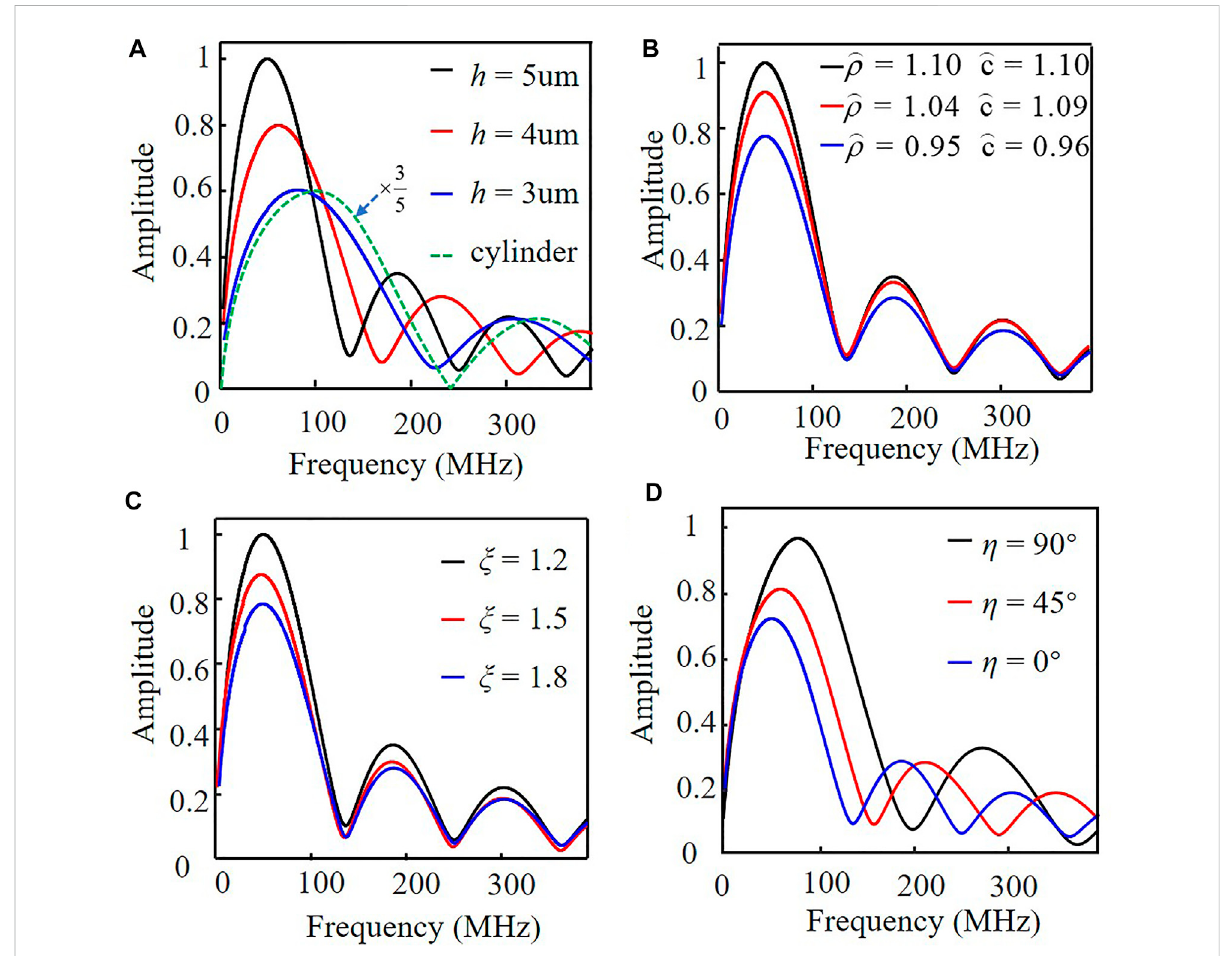
Calculated photoacoustic spectral amplitude ofthe fl uidic ellipticcylinder with respect to (A) focal radius h , (B) density ρ c and acoustic speed c , (C) detecting distance ξ , and (D) polar angles η